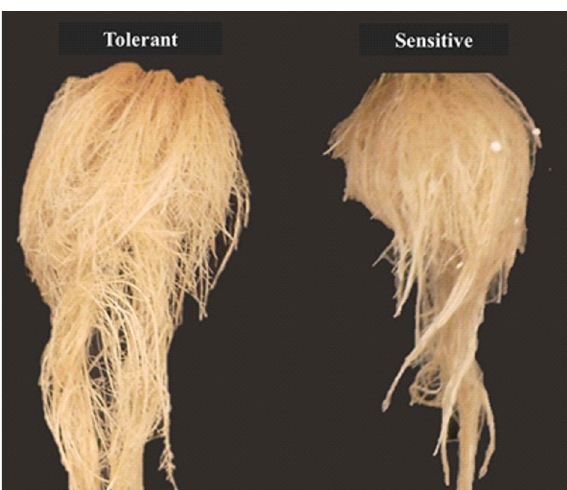
Figure 9. Image of the root of the cv. tolerant and sensitive in conditions of severe P-deficiency proposed by Marques et al.